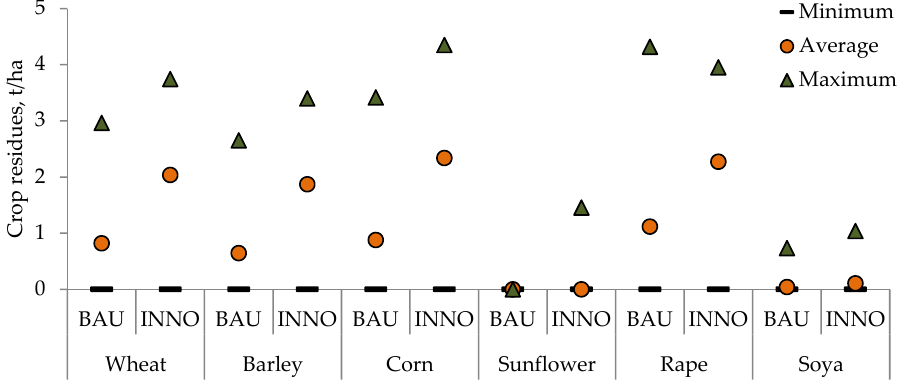
Figure 6. Amount of crop residues available for bioenergy generation purposes while satisfying agro-environmental requirements. Source: own calculations.